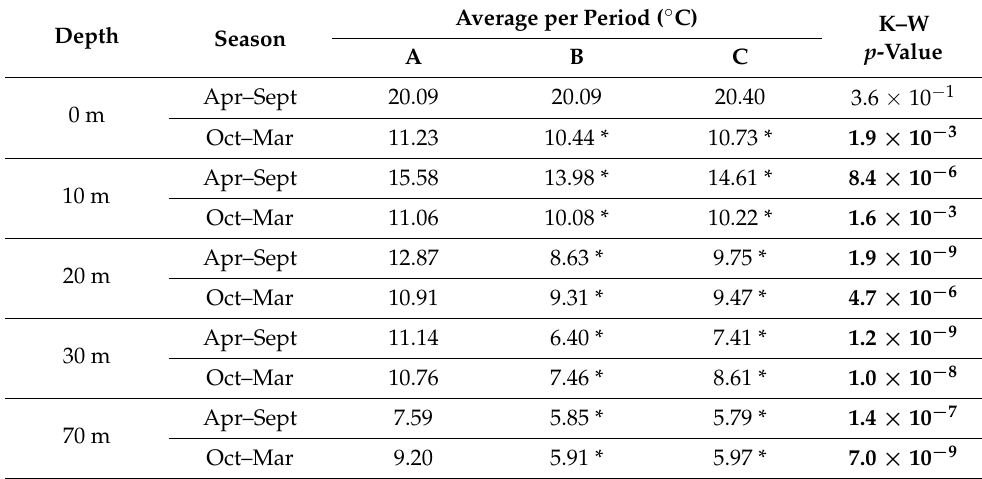
Table 3. Results of Kruskal–Wallis (K–W) and rank-sum tests at α = 0.05 for water temperatures at various depths. Significantly different p -values are in bold characters.